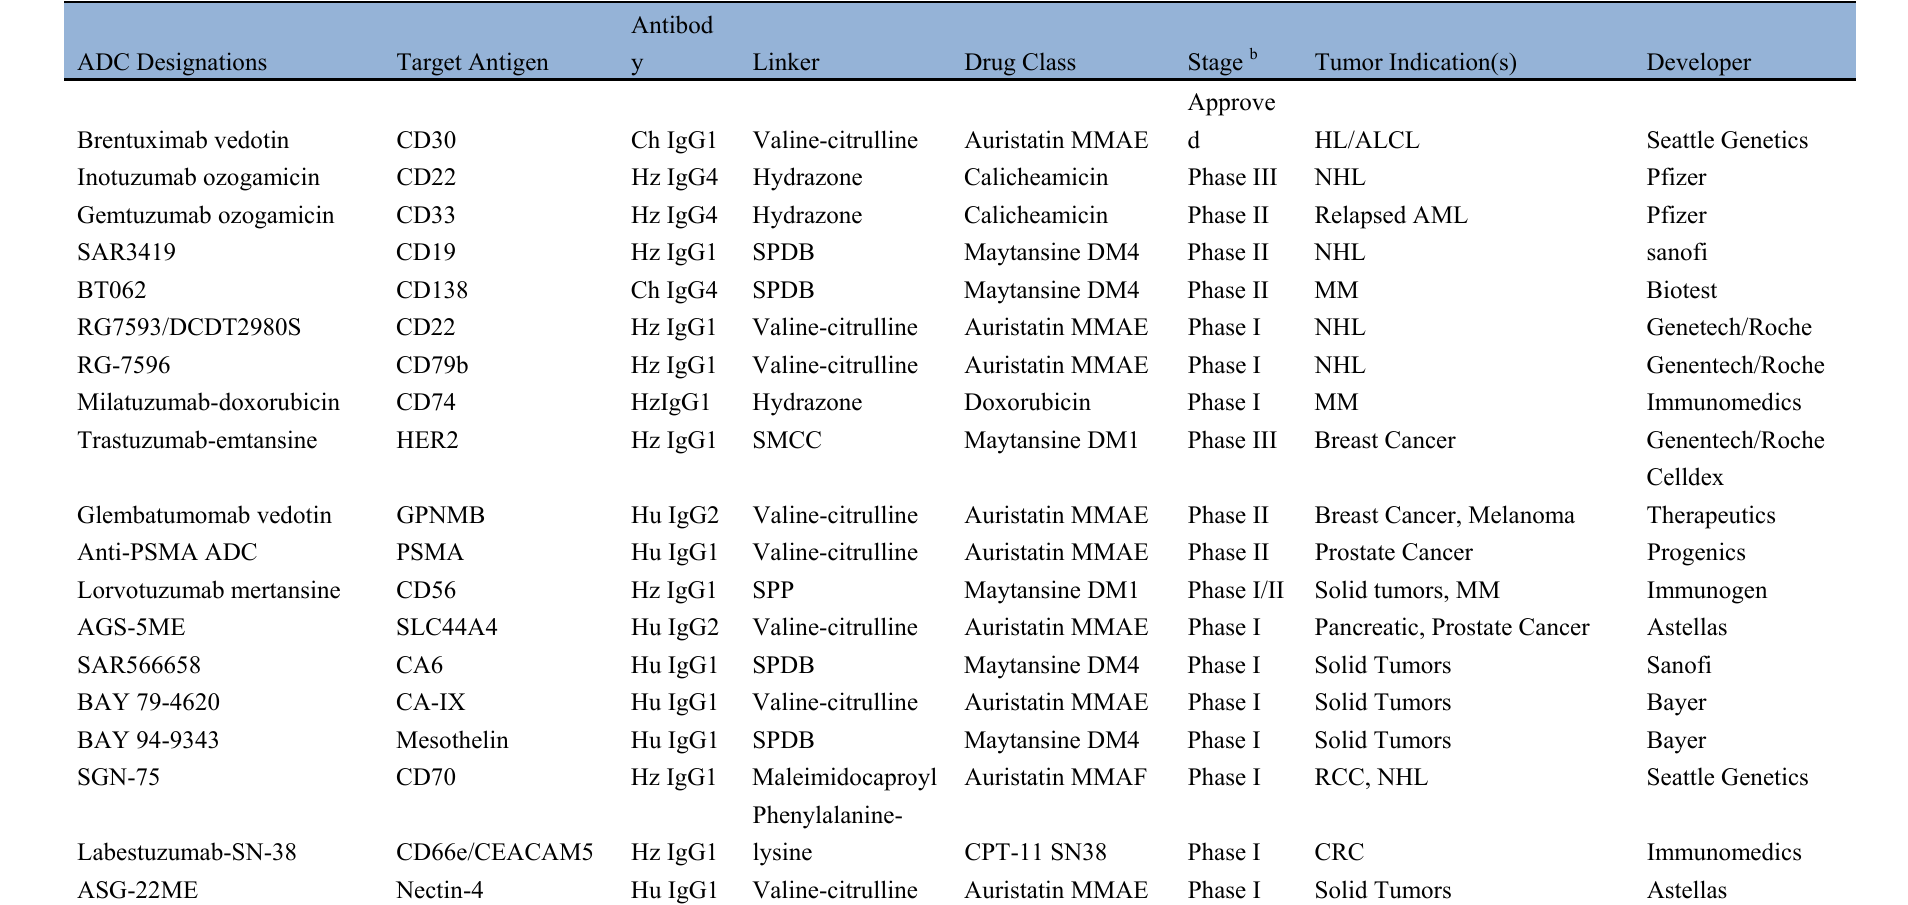
Table 1. Antibody drug conjugates currently in clinical development a